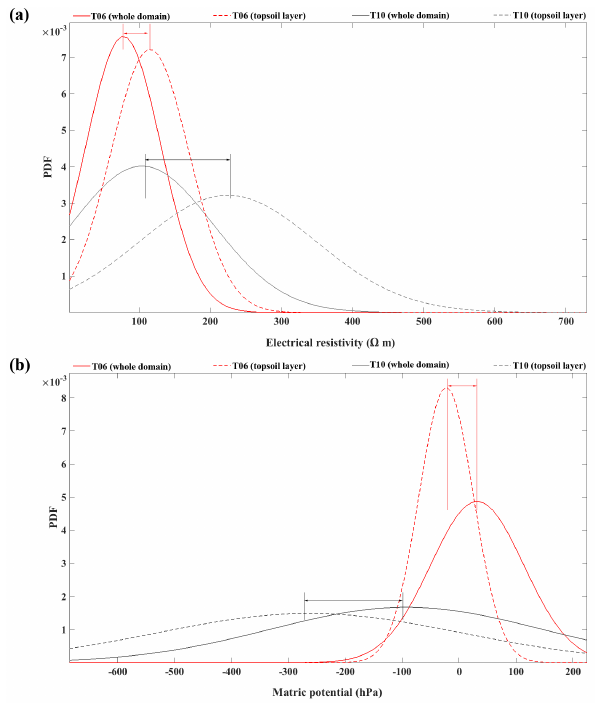
Figure 6. Probability density functions (PDF) of (a) electrical re- sistivity and (b) matric potential between wet (T06) and dry (T10) states for the entire domain (solid line) and the topsoil layer (dashed